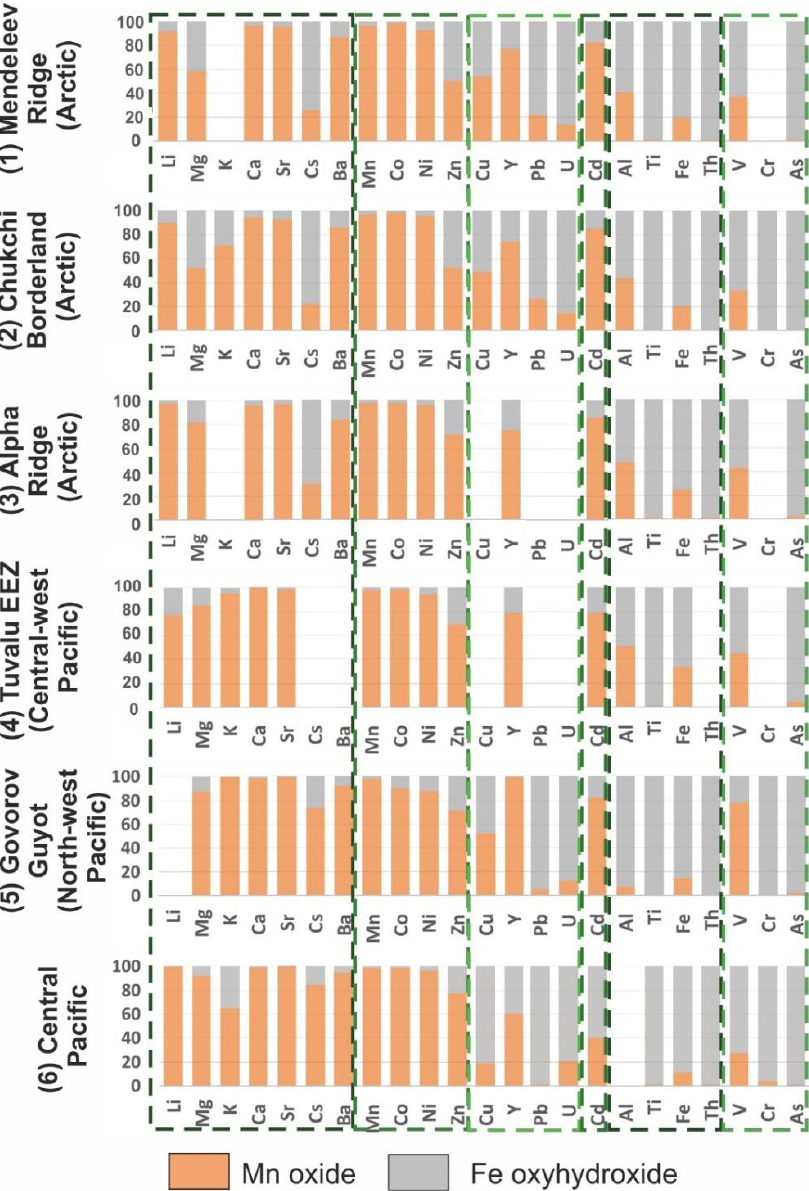
Figure 9. Element associations with MnO 2 (L2) and FeOOH (L3) in same groups of crusts as in Figure 8.